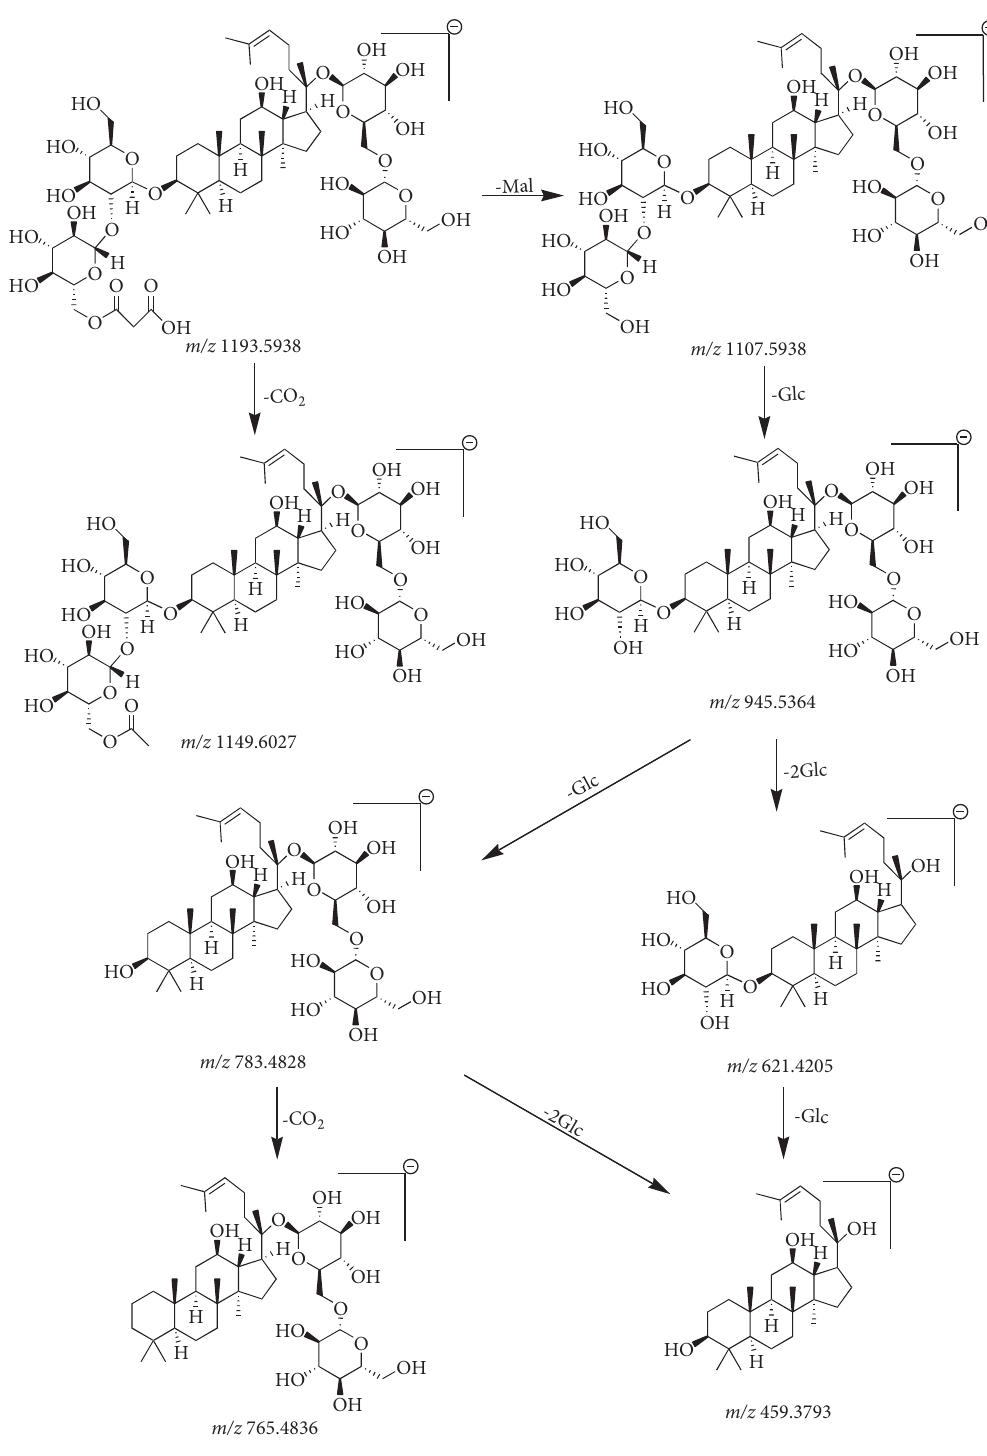
Figure 5: The fragmentation pathway of malonyl-ginsenoside Rb